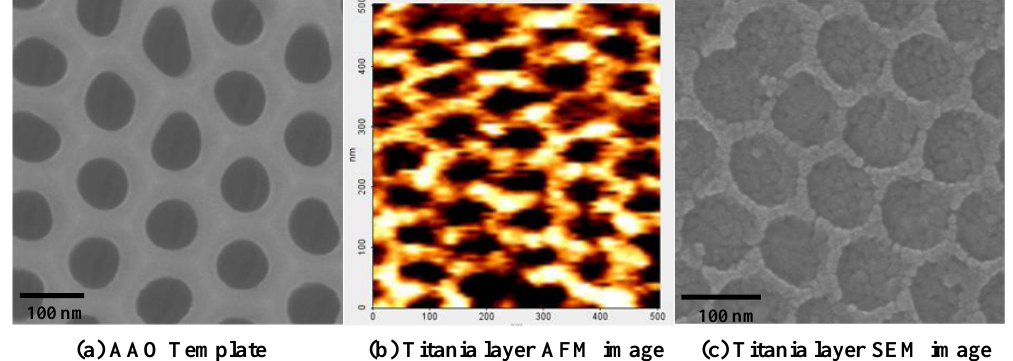
Figure 4. Nanopore image: (a) AAO template using FE-SEM, (b) imprinted Titania layer AFM image, (c) FE-SEM